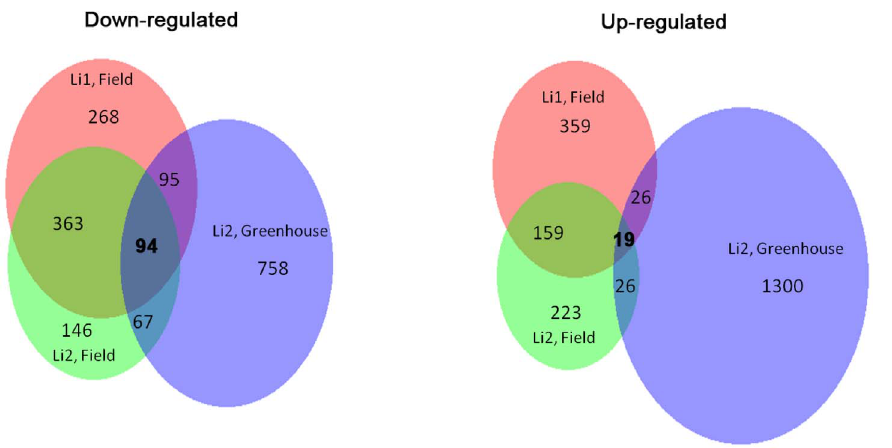
Figure 4. Venn Diagrams illustrating the similarities and differences between the experimental groups. Each number represents the number of probes showing different expression levels ( . 2 fold difference) between the mutants and the wildtype near-isogenic